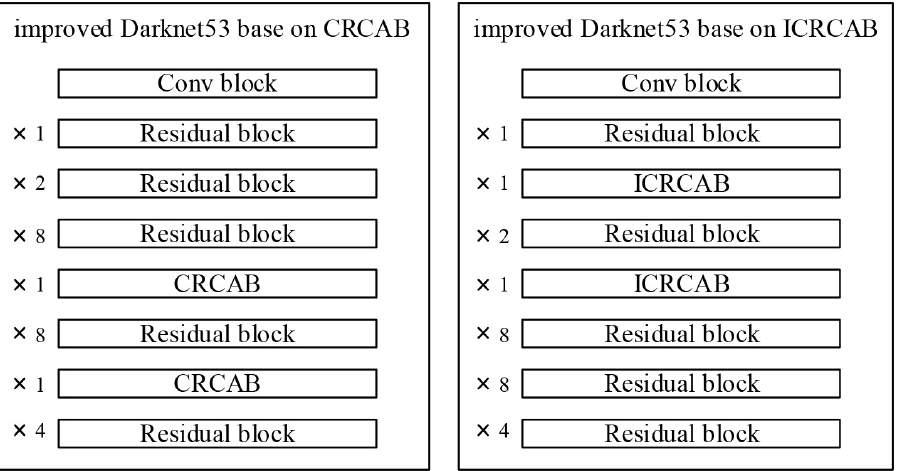
Figure 9. Improved Darknet53 based on CRCAB and